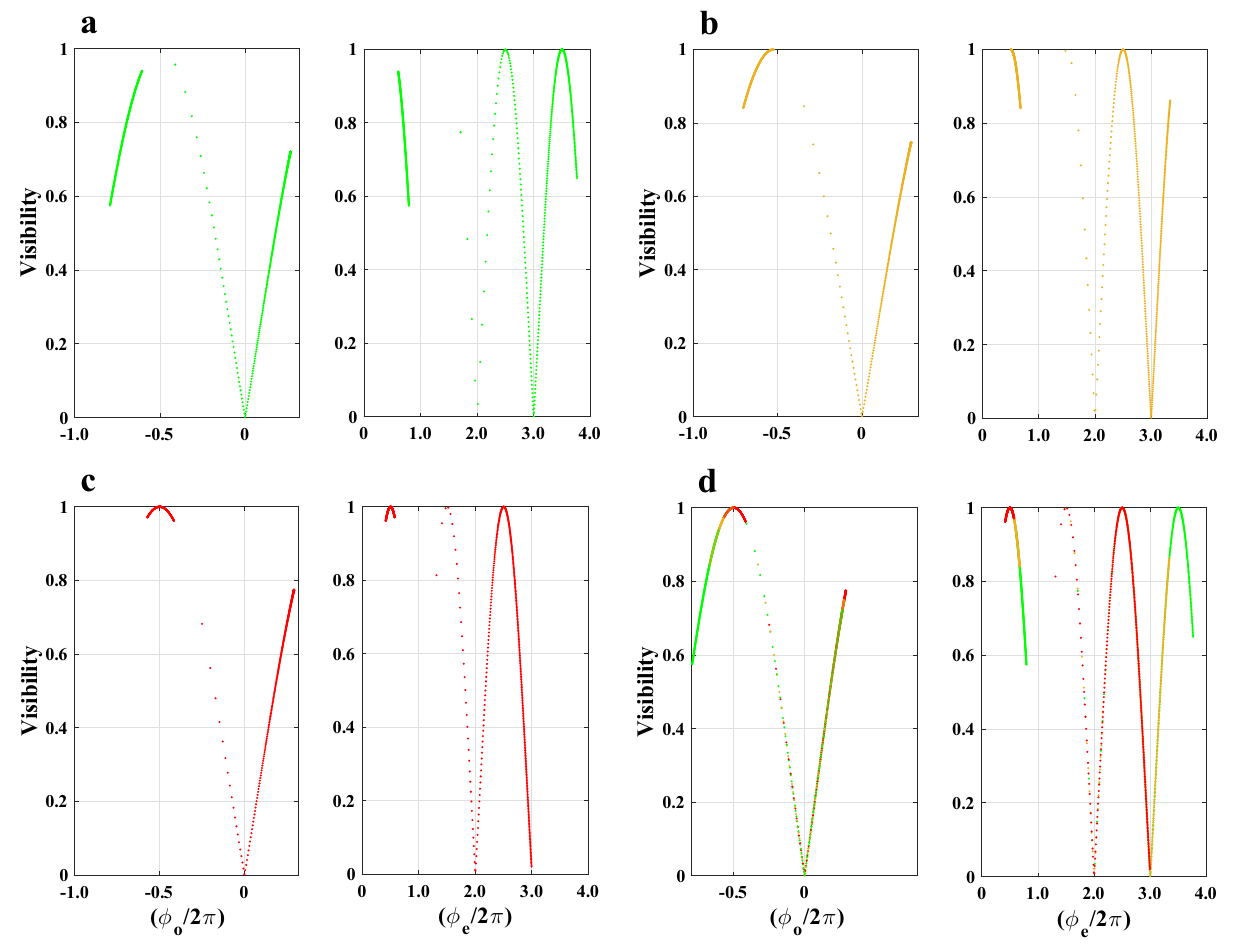
Figure 6. At three wavelengths, (cid:31) 0 = 549, 589 , and 633 nm, the visibility curves of the diffracted fringes as functions of ordinary and extraordinary normalized phase differences corresponding two phase steps have maximum value for m = ± 1 / 2, ± 3 / 2, . . . , and zero value for m = 0, ± 1, ± 2, . . .